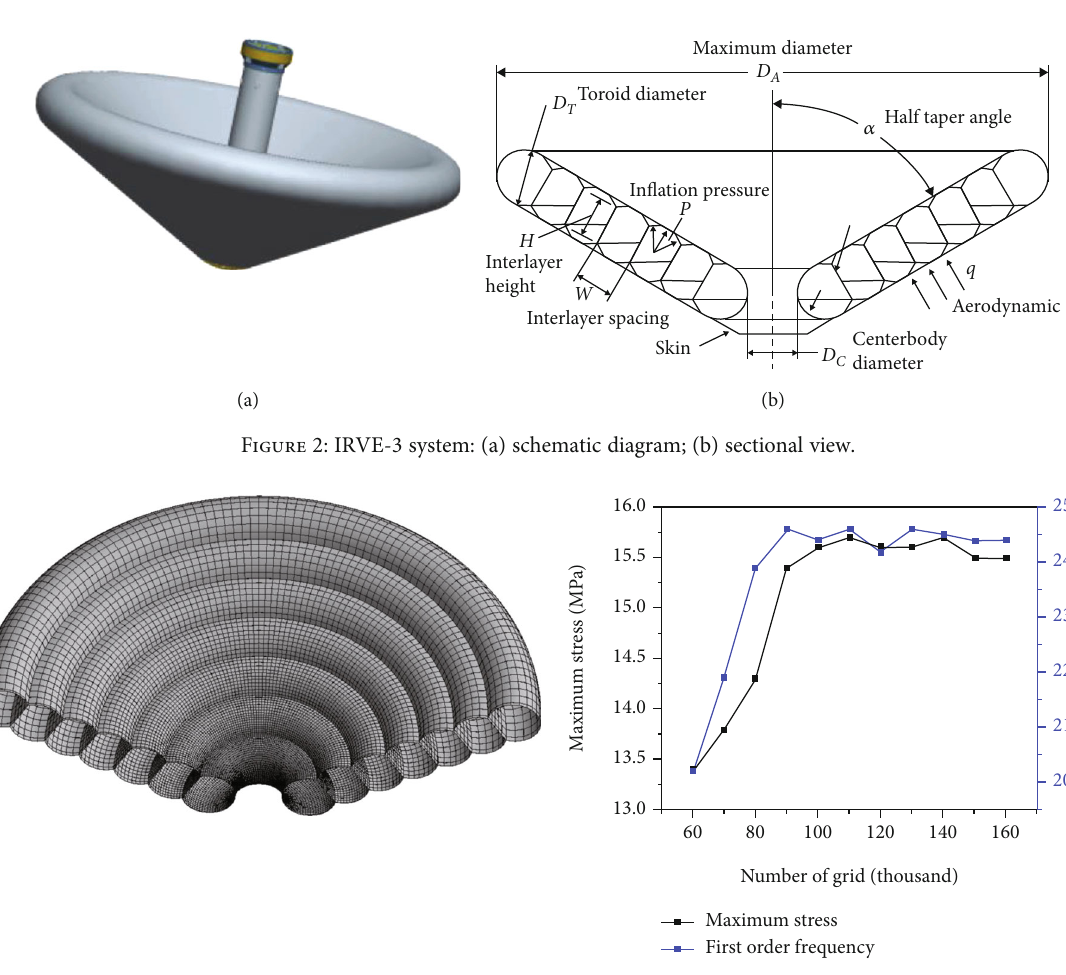
Figure 1: Thermal- fl uid-solid coupling scheme in this paper.